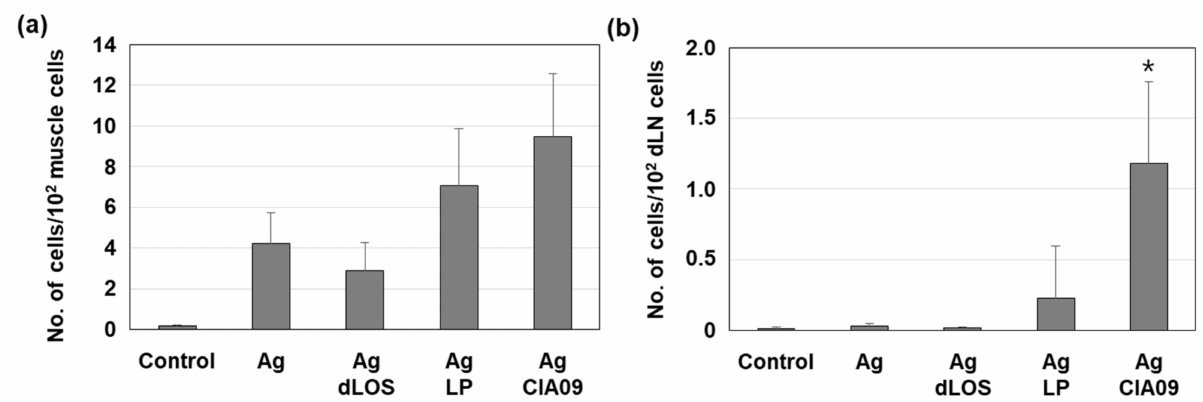
Figure 10. Increased antigen delivery to lymph nodes in the mice administered CIA09-adjuvanted gE antigen. Groups of mice ( n = 3) were given an intramuscular injection with AF647-labeled gE antigen (10 µ g), alone or in combination with dLOS (3 µ g), liposomes (LP) (100 µ g), or both. Cells were collected from the muscles at SOI ( a ) and draining lymph nodes ( b ) at 24 h post-injection and analyzed for antigen-positive cells by flow cytometry. Results are expressed as the mean ± SD of values obtained from 3 mice for each group. * p < 0.05 as compared with the group given antigen alone or antigen plus